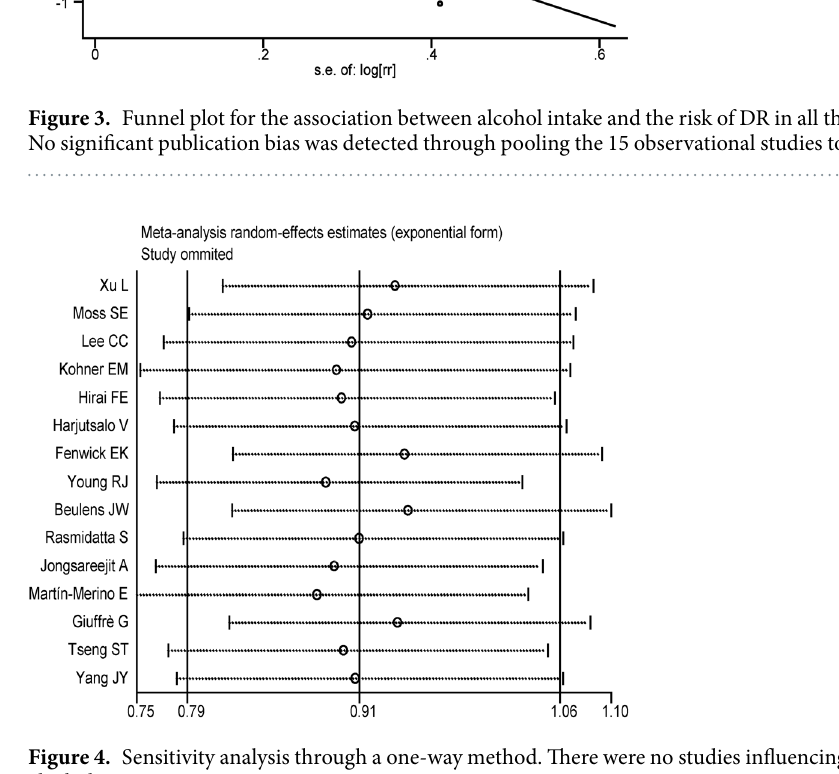
Figure 4. Sensitivity analysis through a one-way method. There were no studies influencing the result of alcohol consumption on